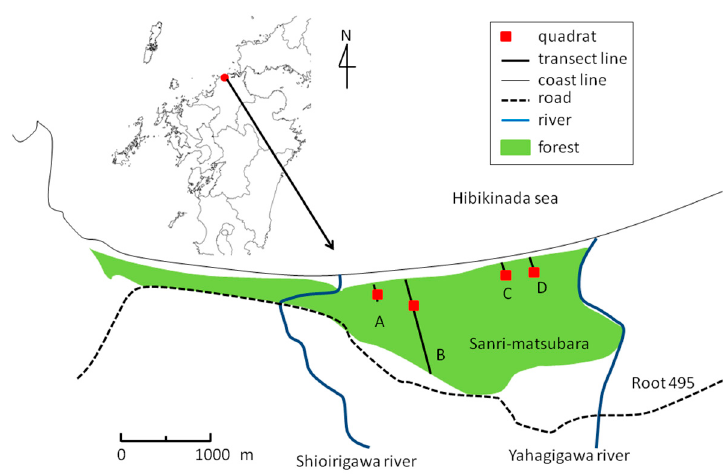
Figure 1. Map showing the Sanri-Matsubara Forest, south-western Japan, and the position of quadrats (20 m × 20 m).